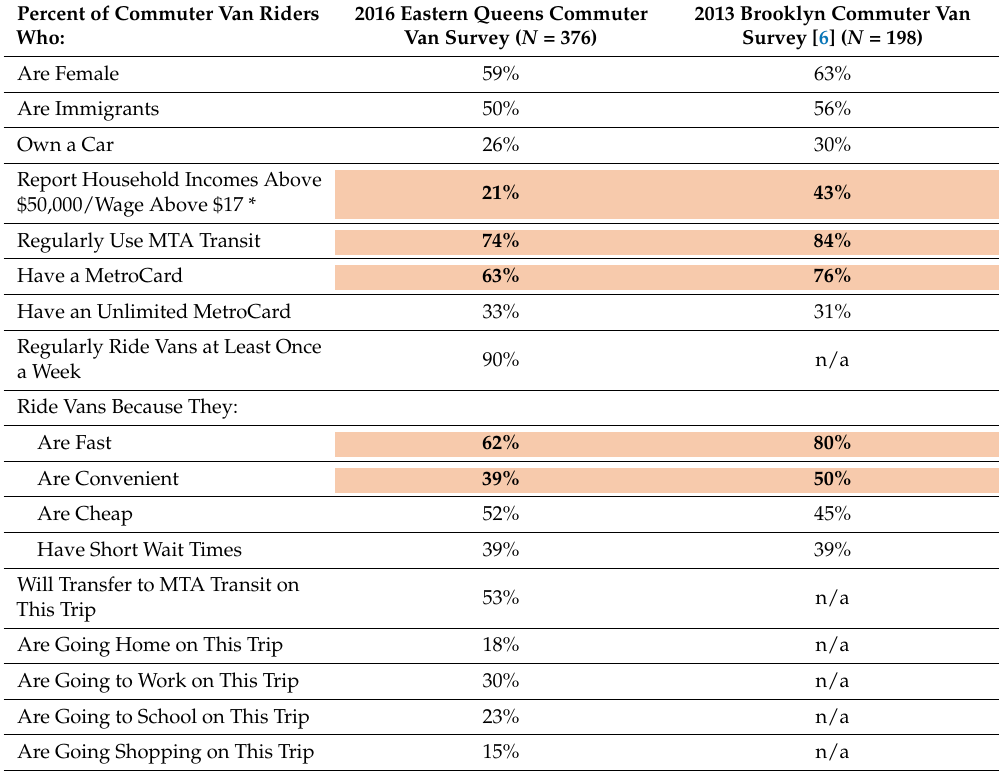
Table 1. A Comparison of